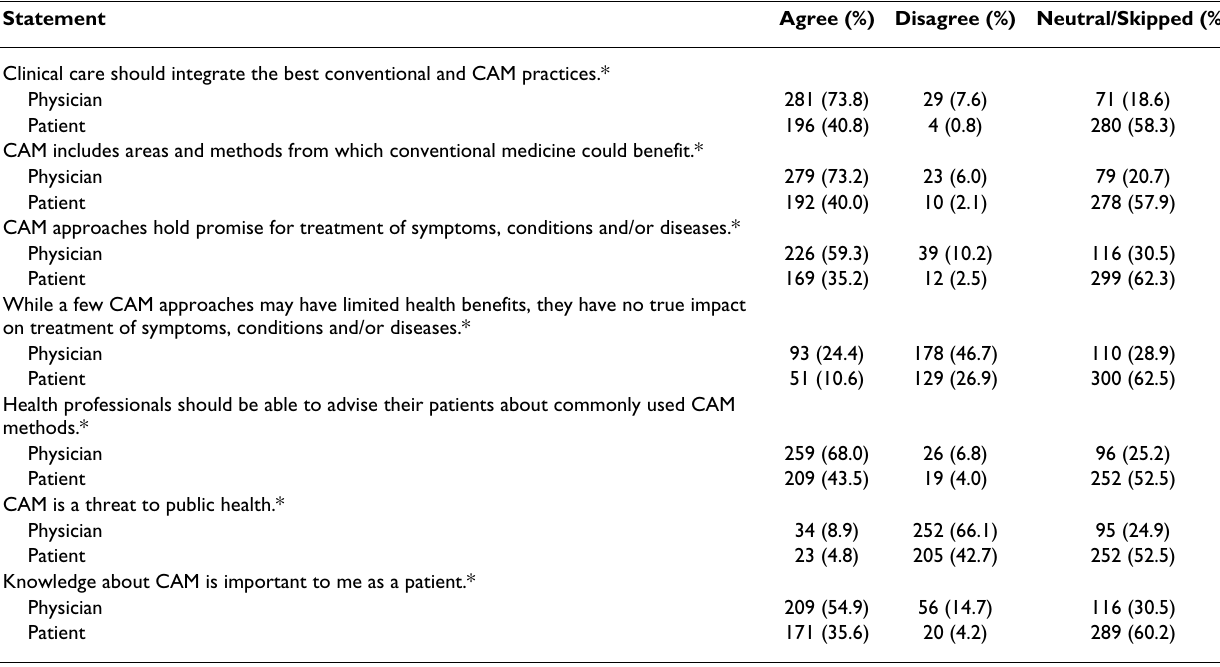
Table 1: Physician and patient attitudes towards complementary and alternative medicine (CAM) Statement